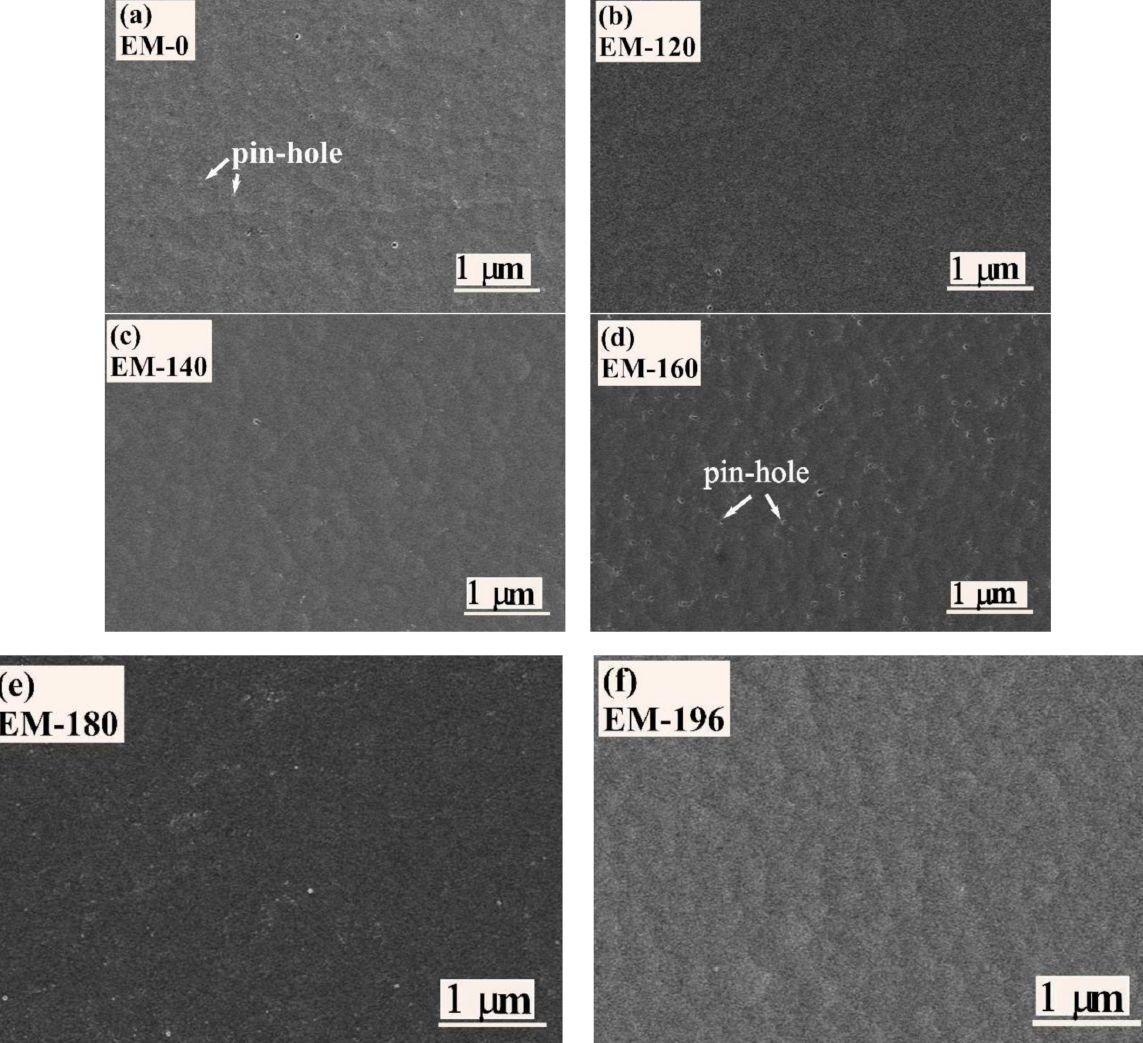
Figure 1. SEM images of top-surface morphologies of different specimens ( a – f